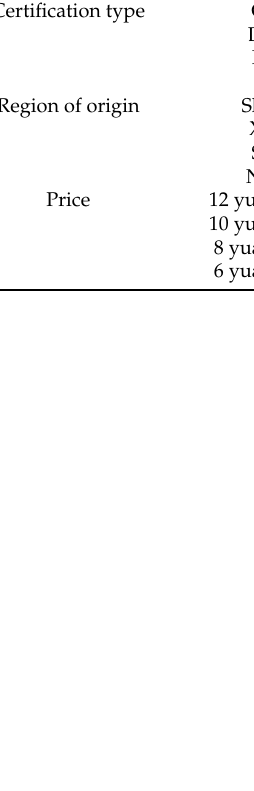
Table A2. Comparison of socio-demographic characteristics between participants in % of the six